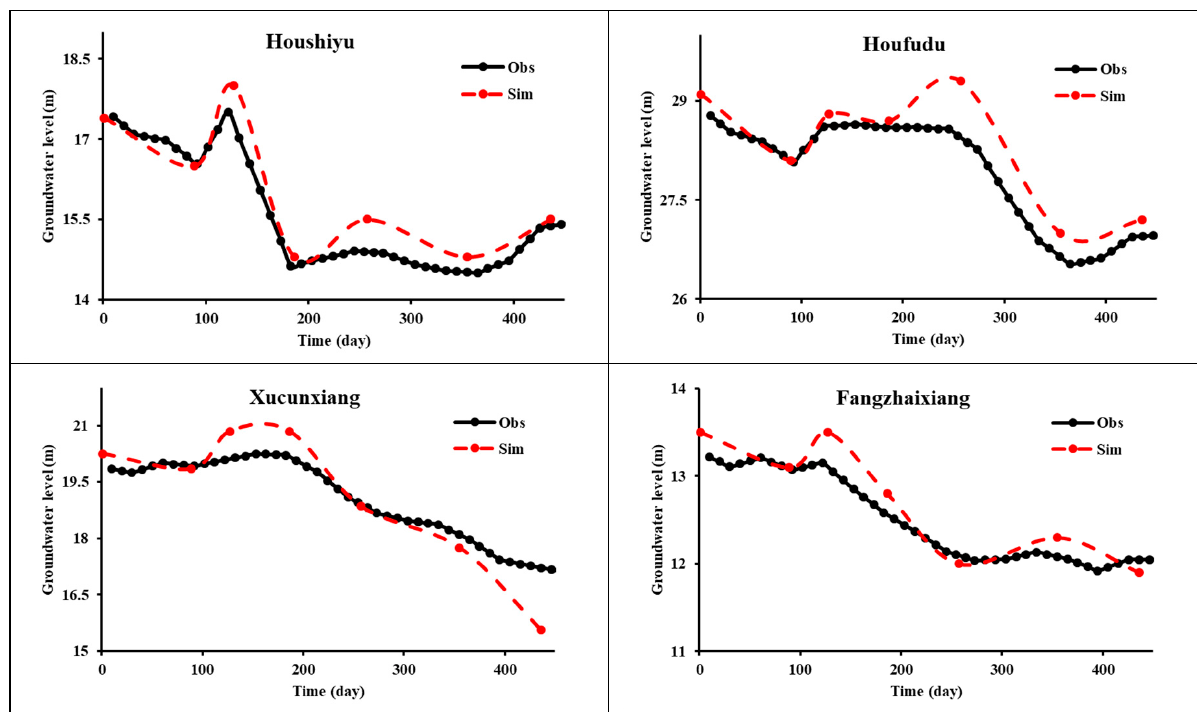
Figure 7. Comparison between measured and simulated groundwater level in partial typical moni- toring wells. Table 3. Groundwater model simulation error statistics results.